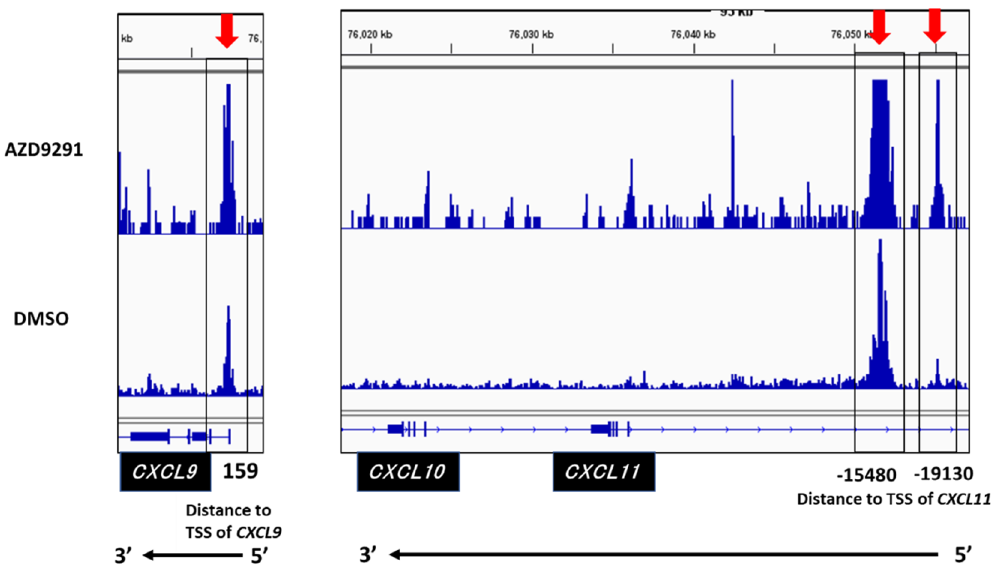
Figure 3. Assay for transposase-accessible chromatin using high-throughput sequencing (ATAC-seq) analysis of the sequences near CXCL9 , CXCL10 , and CXCL11 in AZD9291-treated EGFR-mutated ( EGFR- mt) lung adenocarcinoma (LA) cells. Treatment with AZD9291 generated three open chromatin peaks. One is in the first intron of CXCL9 (+ 159 bp from the transcription start site (TSS)), while the other two are in the 5 ′ region of CXCL11 (− 15,480 and − 19,130 bp from the TSS) (arrows and rectangle boxes). The large peak at the 15 kb region upstream of CXCL11 comprises three merged